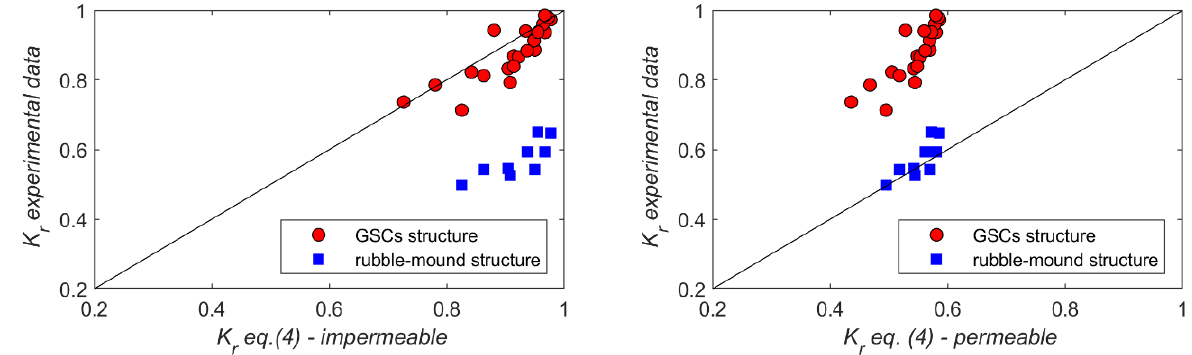
Figure 9. Comparison of the experimental reflection coefficient of the GSC structure (circle red data) and rubble mound structure (blues square data) with Equation (4), proposed by Seeling and Arhens (1981) for impermeable ( left panel ) and permeable ( right panel ) structures.